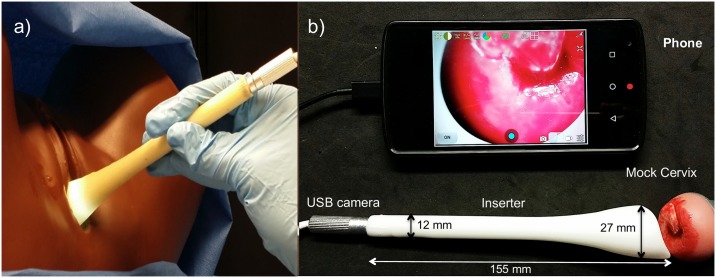
(a) Vaginal Inserter with digital colposcope inserted, imaging a mannequin cervix with white LED illumination. (b) Image of the device with dimensions with the mini USB camera inserted and interfacing with the smartphone for imaging. The image shows the camera in the inserter device imaging a mock cervix in real time.